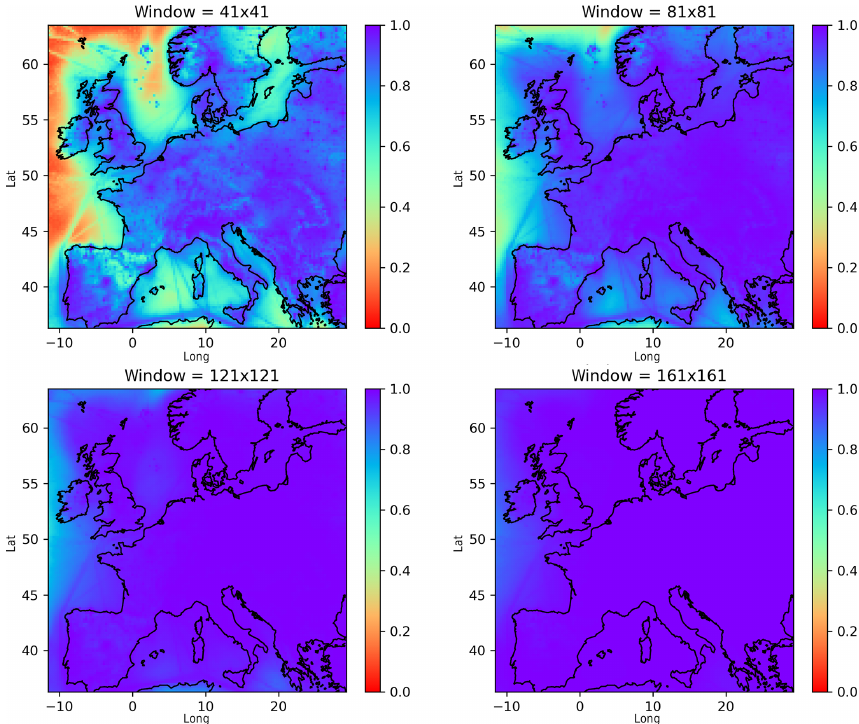
Figure 7. Sum of all local fractions (Eq. 14) for PM 2 . 5 and different sizes of the local region (average for March 2016). The distance is counted as the number of grid cells in each direction. All vertical layers (20) are included. A sum of 1.0 means that all the sources have been accounted